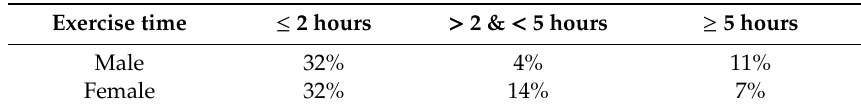
Table 6. Distribution (%) of the volunteers according to the time they spend practising sport along the week.